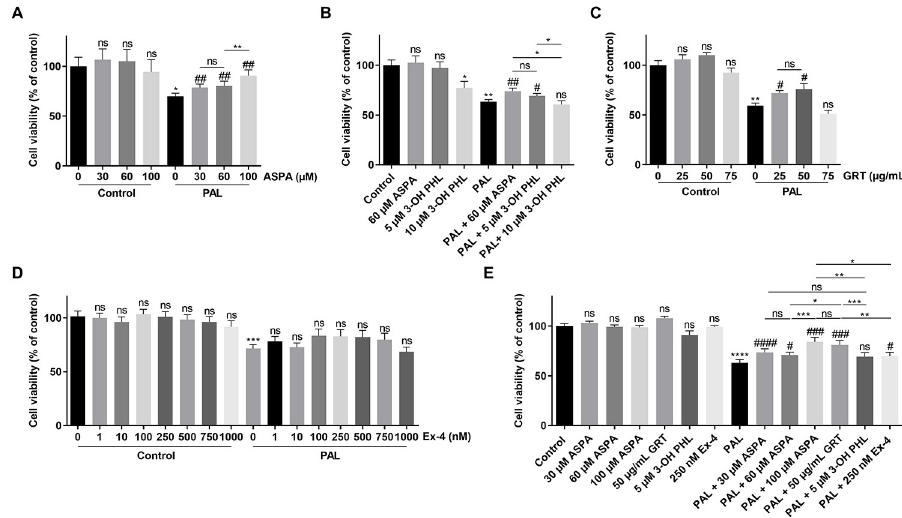
Fig 3. Cytoprotective effect of flavonoid treatment or reference molecule Exendin-4 on INS1E β cells after lipotoxicity. INS1E β cells were cultured in 96-well plates. Cells were treated with (A) Aspalathin (ASPA), (B) 3-hydroxyphloretin (3-OH PHL) or aspalathin (ASPA), (C) GRT, (D) Exendin-4 (Ex-4) or (E) all compounds, at indicated concentrations 24 h prior to 0.5 mM palmitate insult and at the time of palmitate insult. 18 h after palmitate insult, cell viability was measured using MTS assay with. Results represent average of independent plates ± SEM. ASPA (n = 9), 3-OH PHL and ASPA (n = 6), GRT (n = 6), Exendin-4 (n = 8) and all compounds (n = 9). Differences between groups were analysed by paired One-way ANOVA with Sidak’s multiple comparisons test. � above bars indicate comparison against control. # above bars indicate comparison against STZ. � above lines indicate comparison between two treatment groups. Non-significant results are indicated by ns. � p < 0.05, �� p < 0.01, ���� p < 0.0001, #p < 0.05, ##p < 0.01, ###p < 0.001 and ####p < 0.0001.